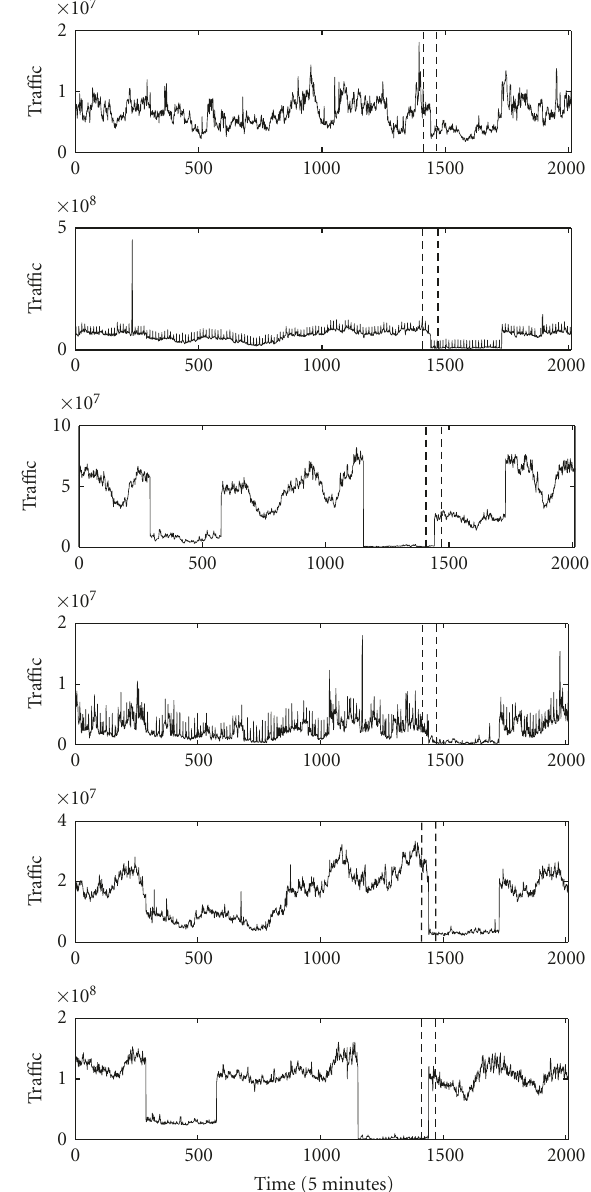
Figure 15: 77, 89, 101, 113, 125, 137 OD flows of 3rd week.